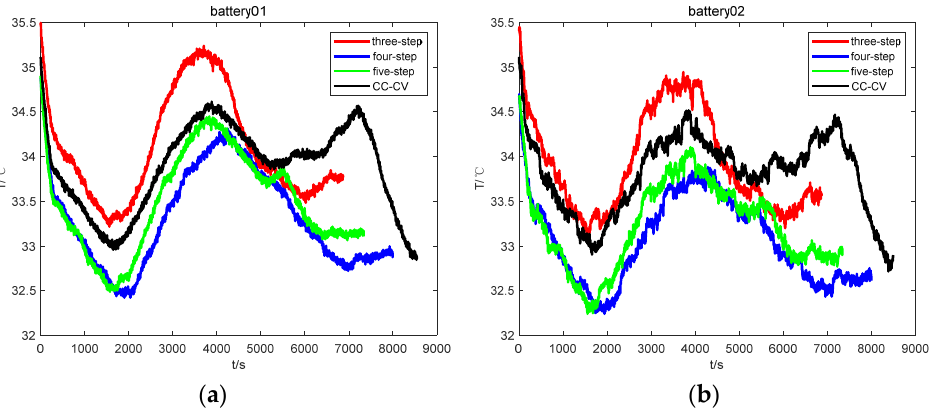
Figure 16. Temperature comparison diagrams between the optimized charging strategy and the constant current–constant voltage charging strategy: ( a ) Battery01; ( b ) Battery02.